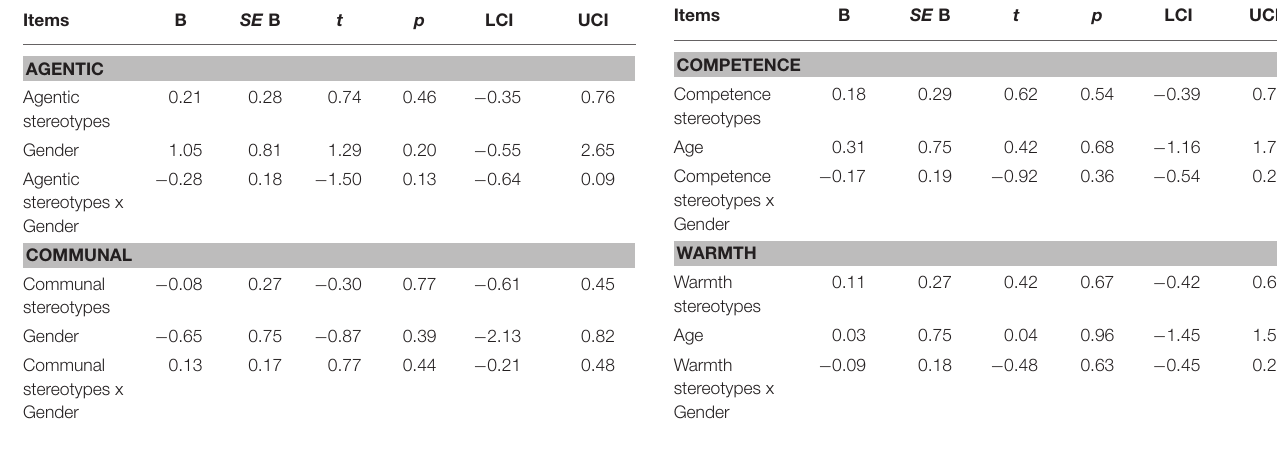
TABLE 2 | Study 1: exploratory moderated regression analysis for gender stereotypes. Items